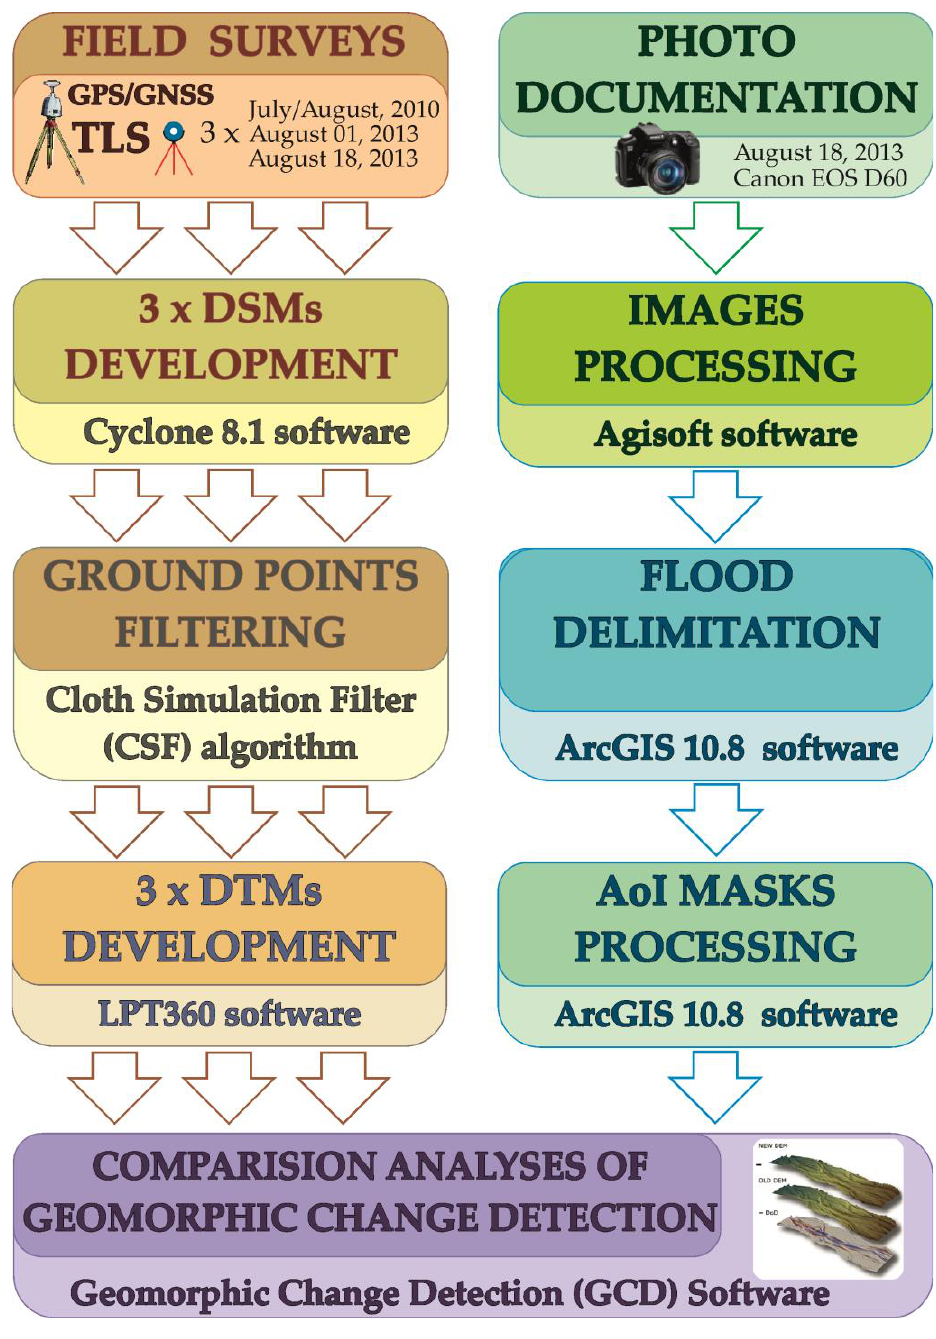
Figure 2. Flowchart of research methodology.